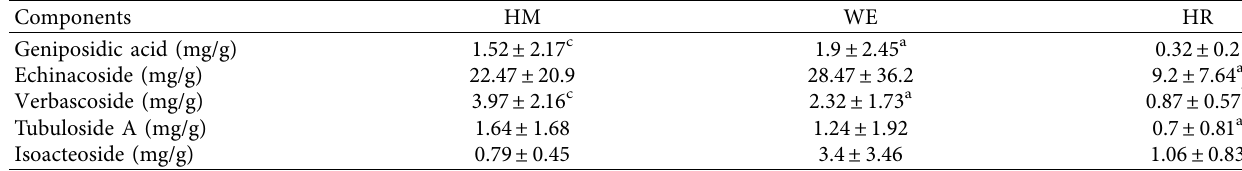
Table 2: Comparison of contents of main components ( n � 11).